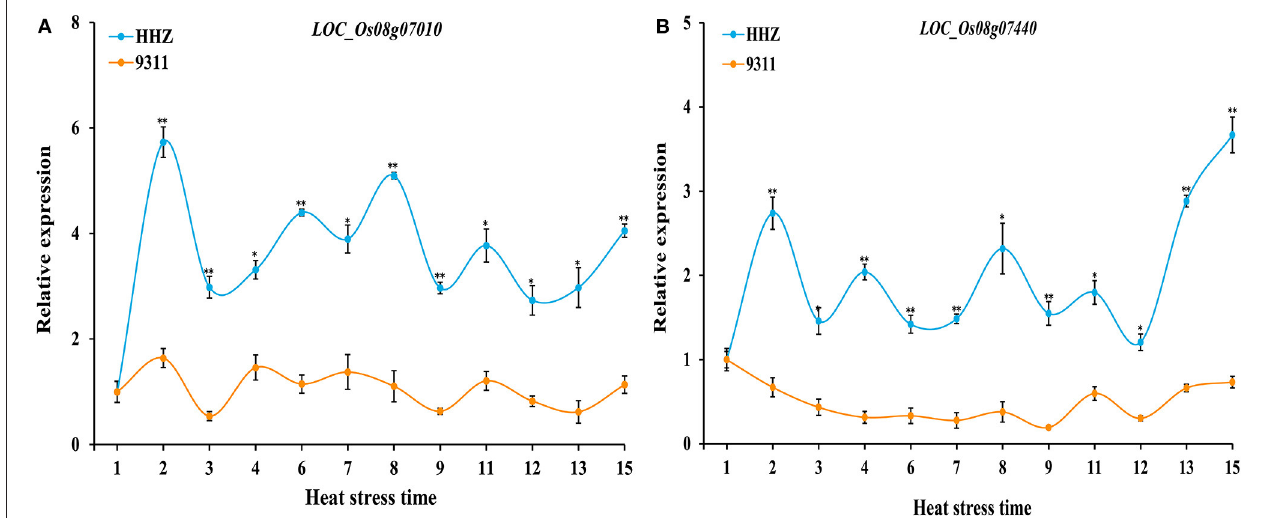
FIGURE 4 | Expression analysis of candidate genes ( A , LOC_Os08g07010 and B , LOC_Os08g07440 ) in HHZ and 9311 under heat stress for different time periods. The relative expression values were normalized to the rice UBQ gene. Error bars indicate standard deviation, and asterisks indicate significant differences using the Student’s t -test (* p < 0.05; ** p < 0.01). X-axis represents the different sampling time period for plants subjected to a 38 ◦ C heat stress in a phytotron; Y-axis represents the relative expression level of